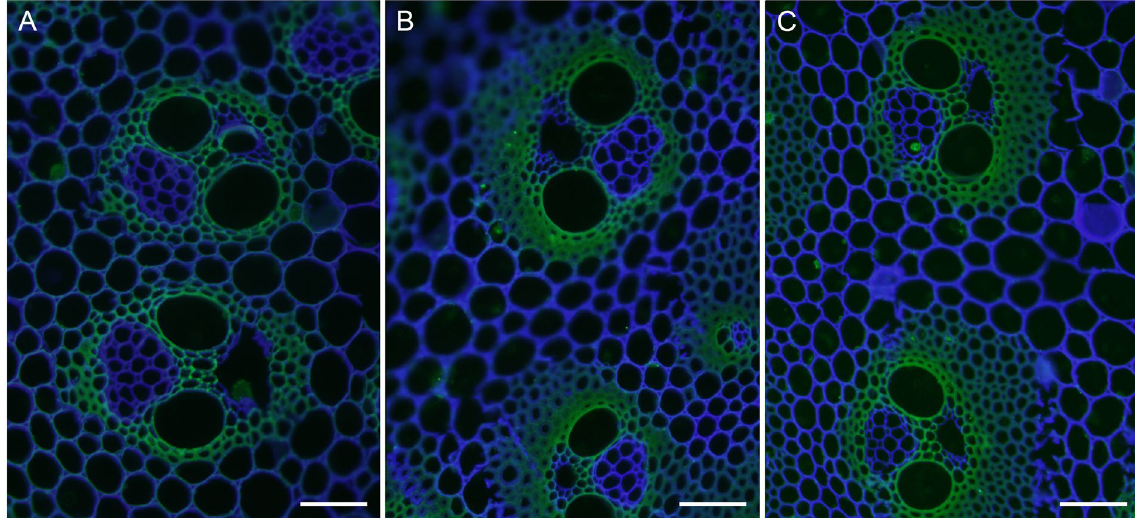
Figure 3. Immunolabeling of crystalline cellulose in an elongating M. lutarioriparius internode. The crystalline cellulose epitope in three sections of M. lutarioriparius internode was immunolabeled with CBM3a. The sections were counterstained with Calcofluor. ( A ) upper internode (UI), ( B ) middle internode (MI), ( C ) basal internode (BI). Bar = 100 μ